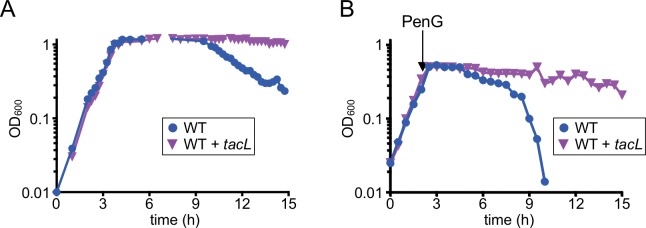
tacL overexpression prevents growth-phase-dependent and antibiotic-induced autolysis.(A) Growth curves of wild-type (WT) Sp and a strain harboring a zinc-inducible tacL allele (WT +tacL) Exponentially growing cultures were diluted into fresh THY at an OD600 of 0.025 in the presence of 100 µM ZnCl2 and incubated at 37°C in 5% CO2. (B) The same strains as in (A) were grown in THY in the presence of 100 µM ZnCl2 to an OD600 of 0.5 and then challenged with penicillin G (0.5 μg/ml final). Growth was monitored approximately every 30 min for 15 hr. Note that tacL overexpression blocks cell lysis in both conditions.